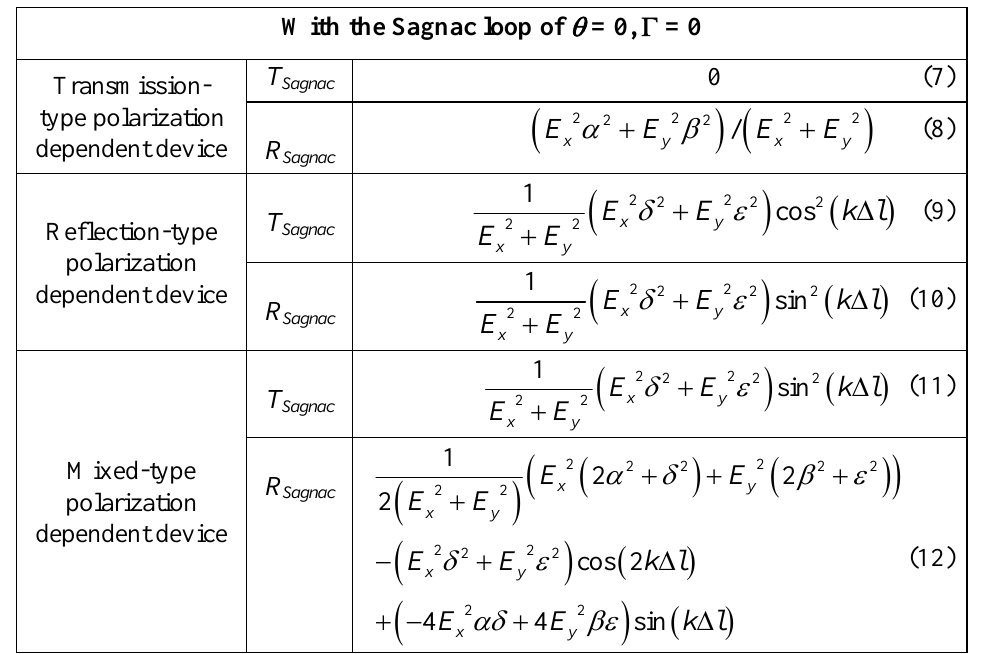
Table 2. The transmittance and reflectance of a Sagnac interferometer with various nested devices exhibiting PDL when the waveplate settings are  = 0 and  = 0.